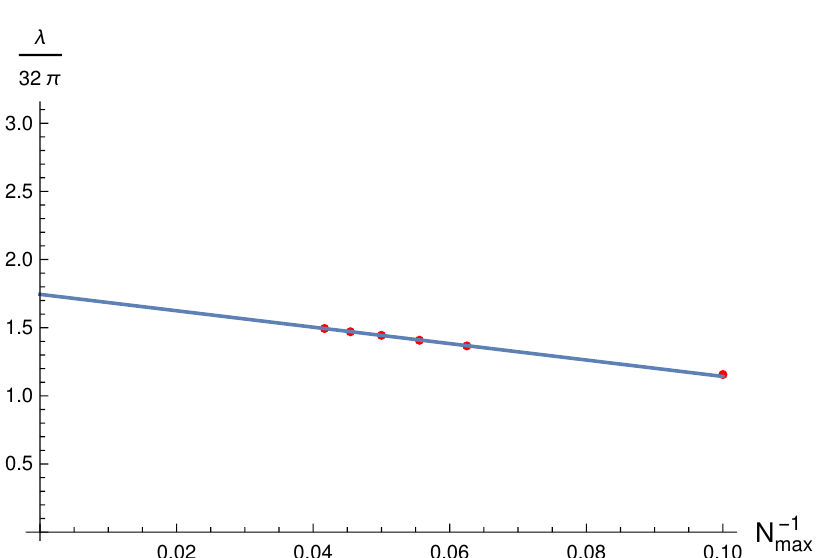
. The numerical results max